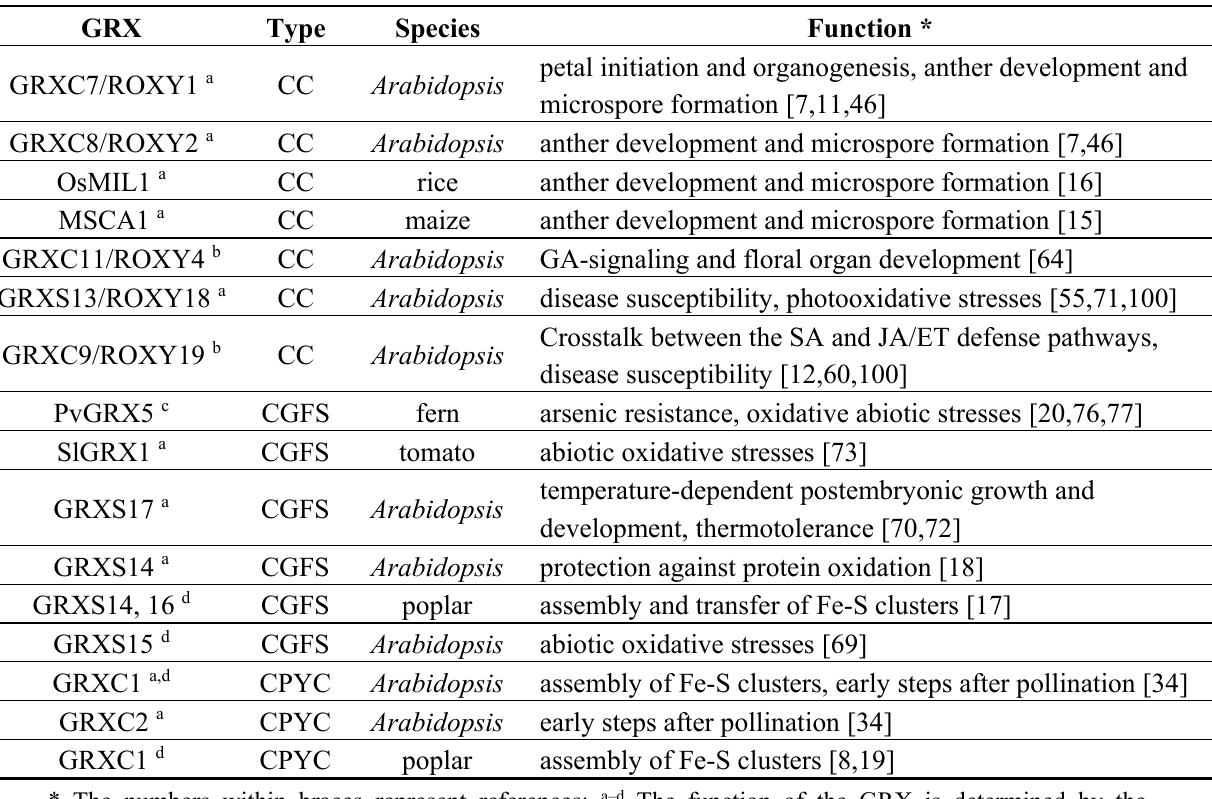
Table 2. A list of functionally characterized GRXs from different plant species. GRX Type Species Function